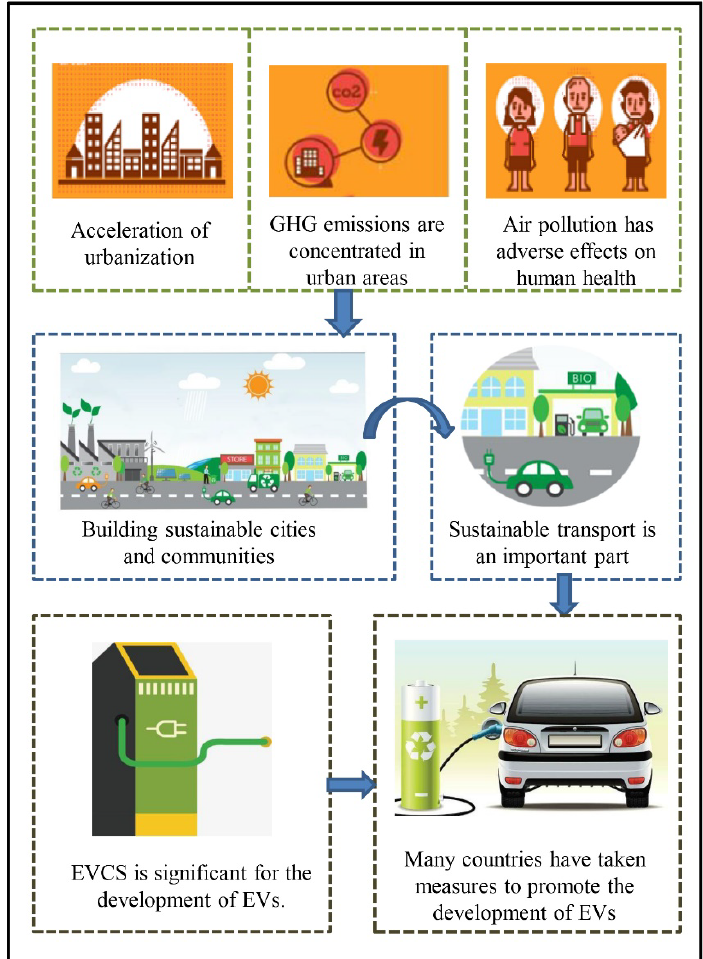
Figure 1. The relationship between electric vehicle charging stations (EVCS) and sustainable cities.